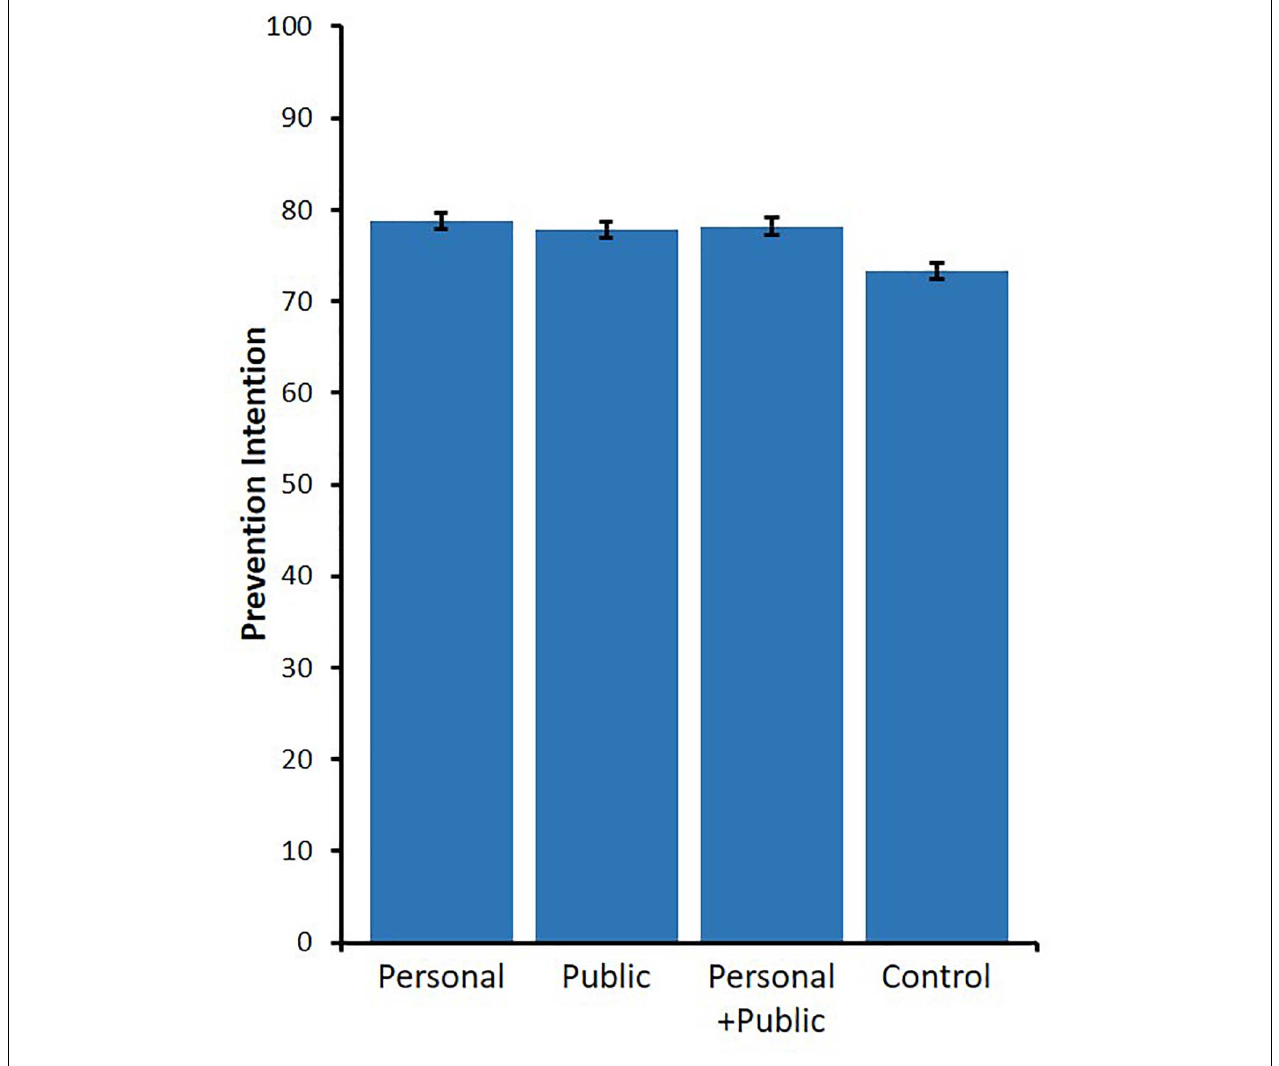
FIGURE 2 | Means of prevention intention per treatments in Study 1 (error bars depict standard